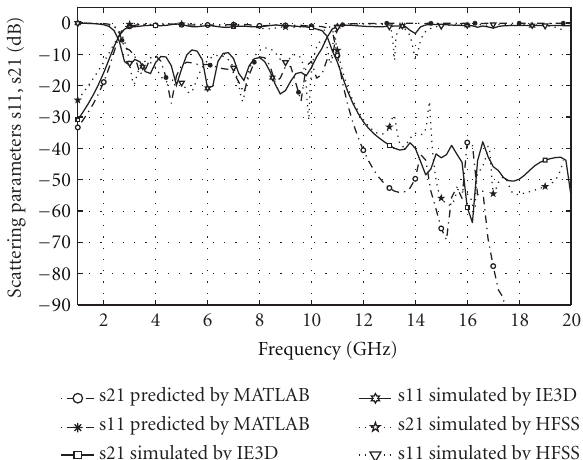
Figure 5: Comparison of the frequency response of proposed multilayered microstrip hairpin filter as obtained by the simulation softwares (IE3D and HFSS) and those predicted by MATLAB (Example 1).